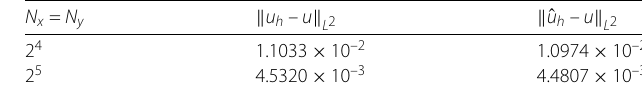
Table 1 The L 2 errors of the collocation schemes (6) and (38) N x = N